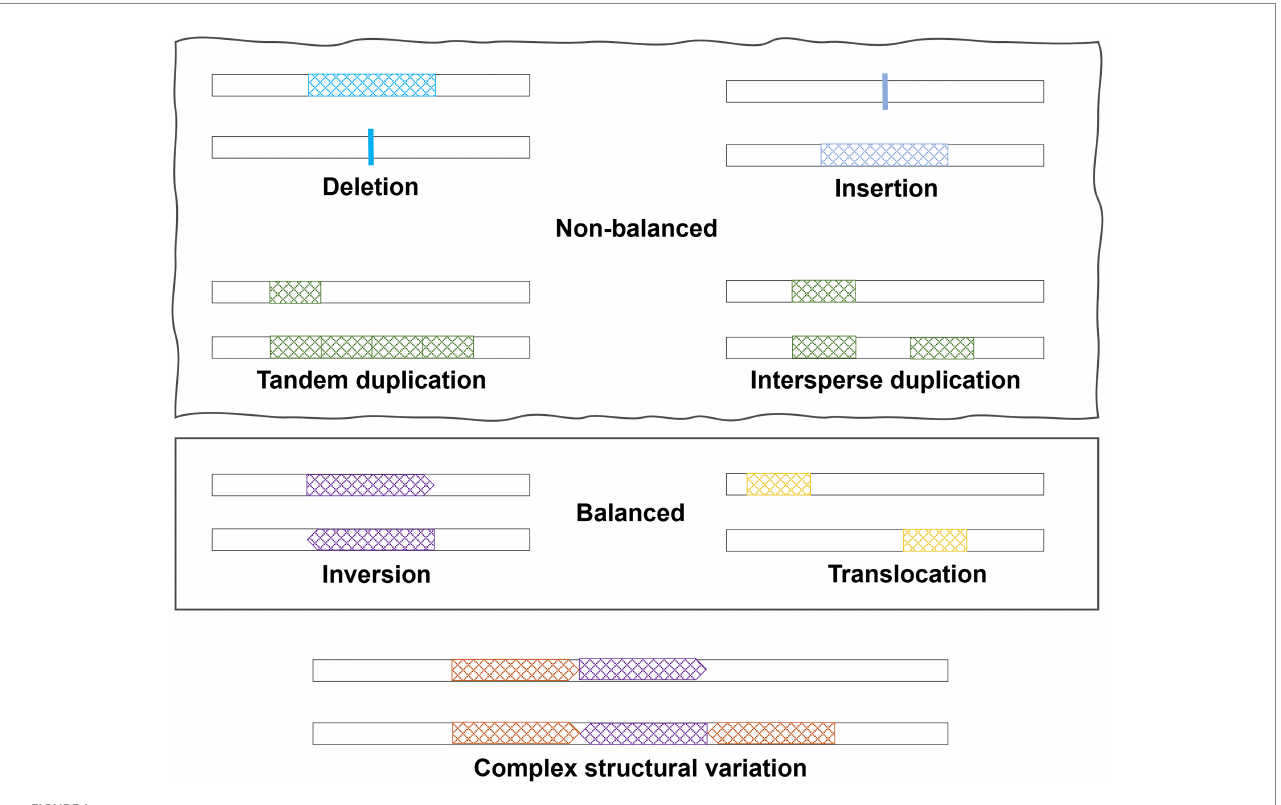
FIGURE 1 Different types of structural